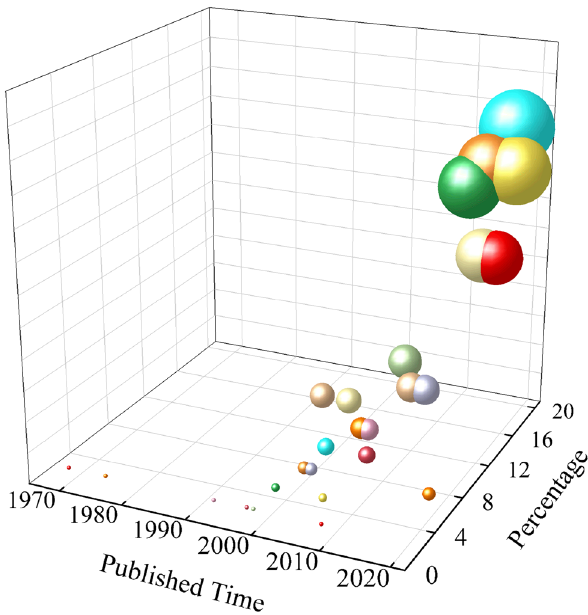
Figure 4: Year of publication of the literature.